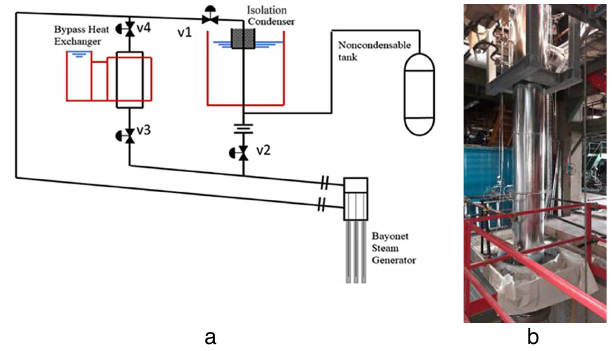
Fig. 1. The SIRIO facility. a. Schematics, b. Steam generator.